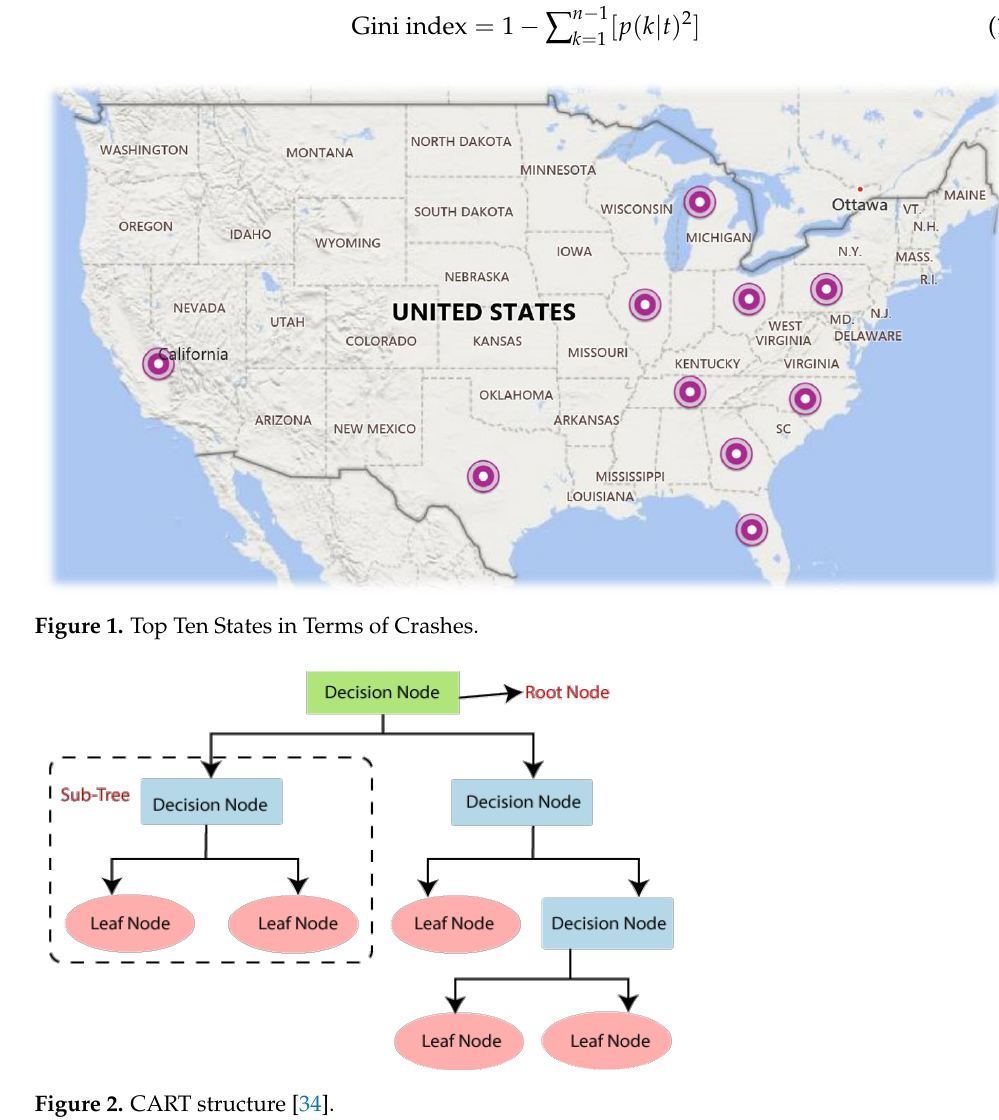
Figure 3. RF Structure [36]. The dataset resulting from the bagging technique is divided into two parts. The first part contains about 2/3 of the dataset and is used for training the individual decision trees. The remaining (1/3 dataset) is called “out-of-bag” and is used for performance evaluation. The decision trees classify out-of-bag elements. The ratio between the misclassified samples and the out-of-bag elements represents the generalization error. The final result for RF is the average of the predictions for regression problems, while the final result for classification problems is the major vote for the predictions. An MLP is a kind of neural network consisting of different layers (i.e., input, hidden, and output layers), and each layer contains perceptrons or nodes. The first layer is the input layer for the input variables, and the final layer is the output layer for the final result. The hidden layer is located between the input and output layers and contains the activation function. Figure 4 shows the structure of the MLP algorithm.